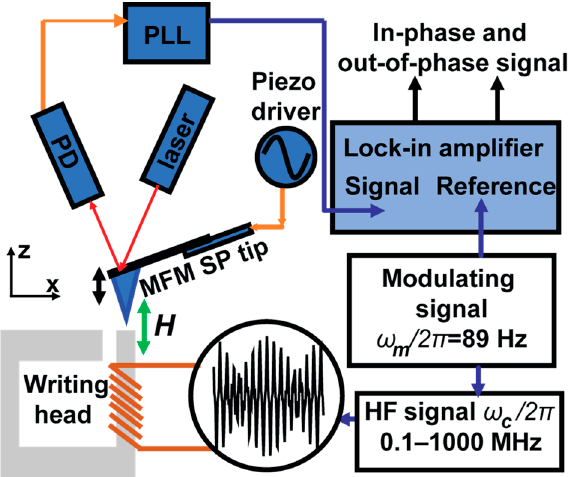
Figure 1. The schematic diagram of high frequency ω c magnetic field imaging by using amplitude modulation with f m (= ω m /2 π ) = 89 Hz, in HF MFM system with SP tip. The difference from the works [1,4,5] is the use of amplitude modulated HF current in the PMR head. The amplitude modulated AC magnetic field H (= H 0 ( 1 + α cos ( ω m t )) cos ( ω c t )) was induced in PMR writing head by applying amplitude modulated AC voltage.